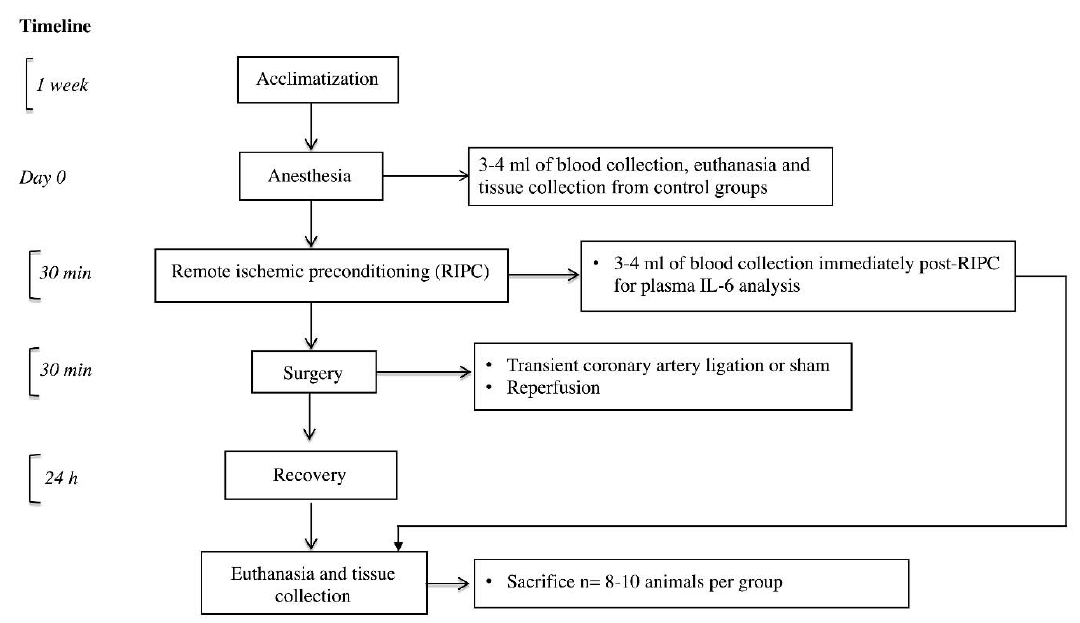
Figure 5. Schematic timeline of the in vivo experiments.